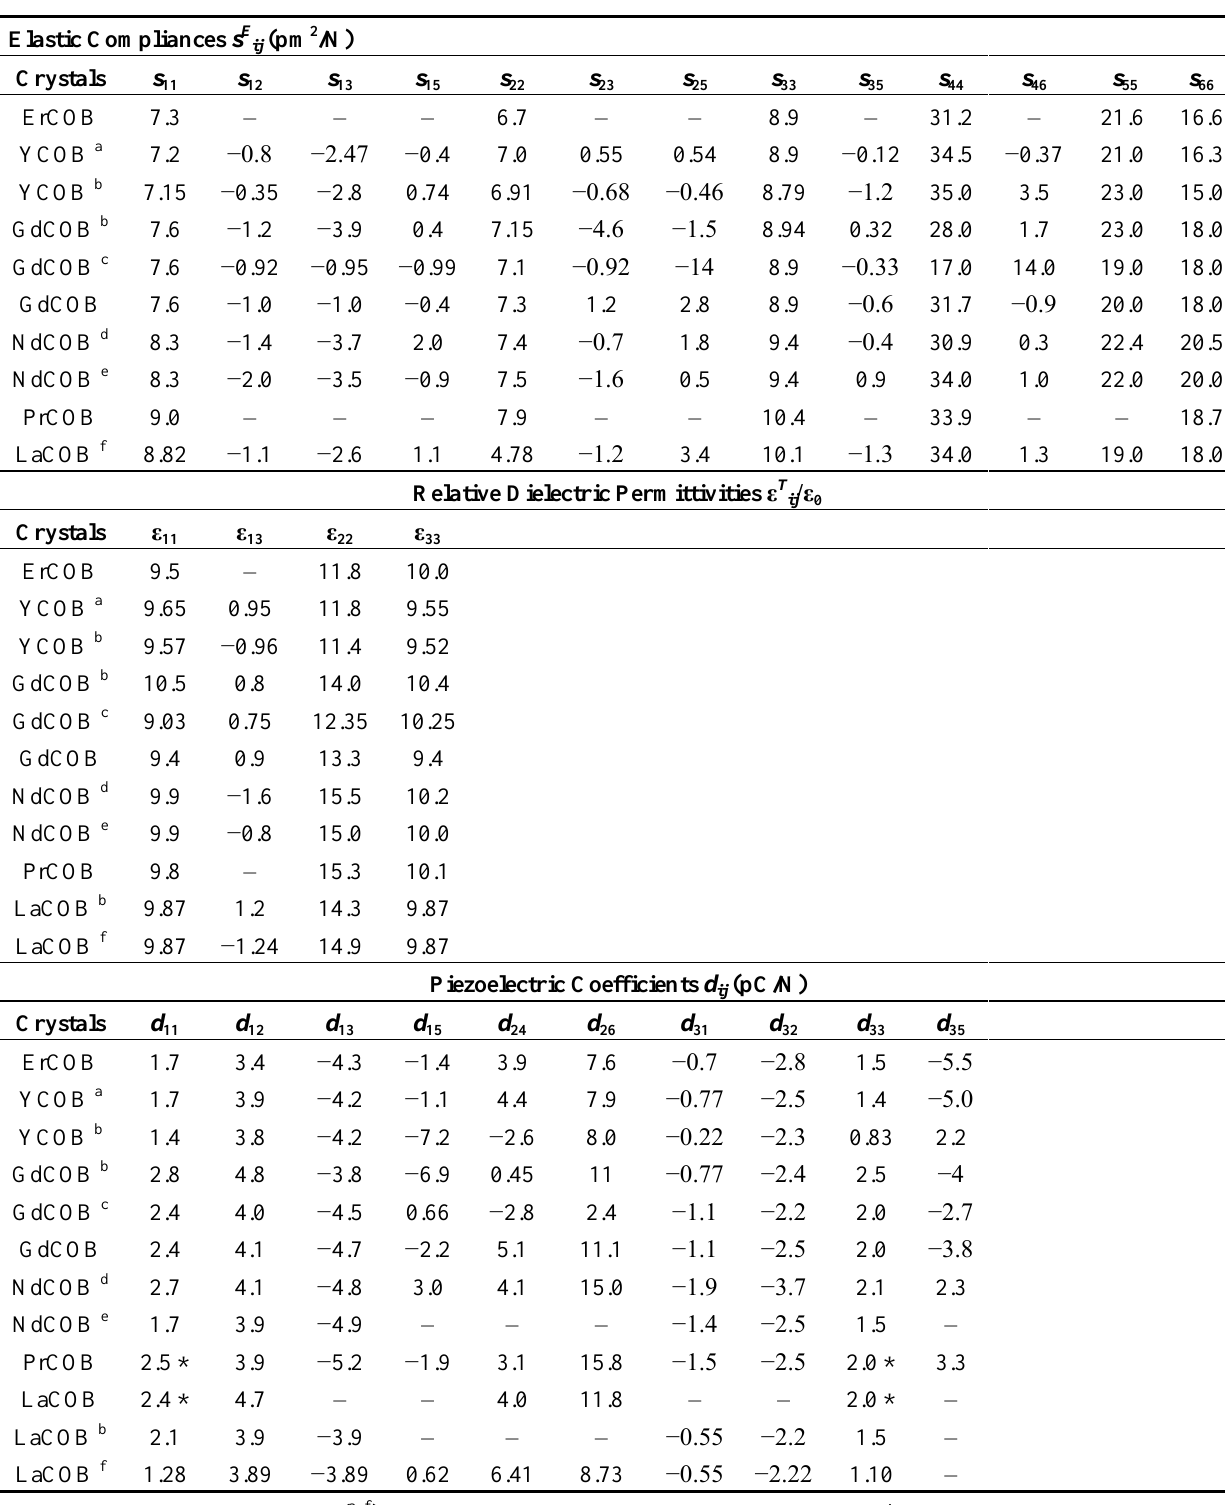
Table 4. Dielectric, piezoelectric and elastic constants of ReCOB (Re = Er, Y, Gd, Nd, Pr and La)